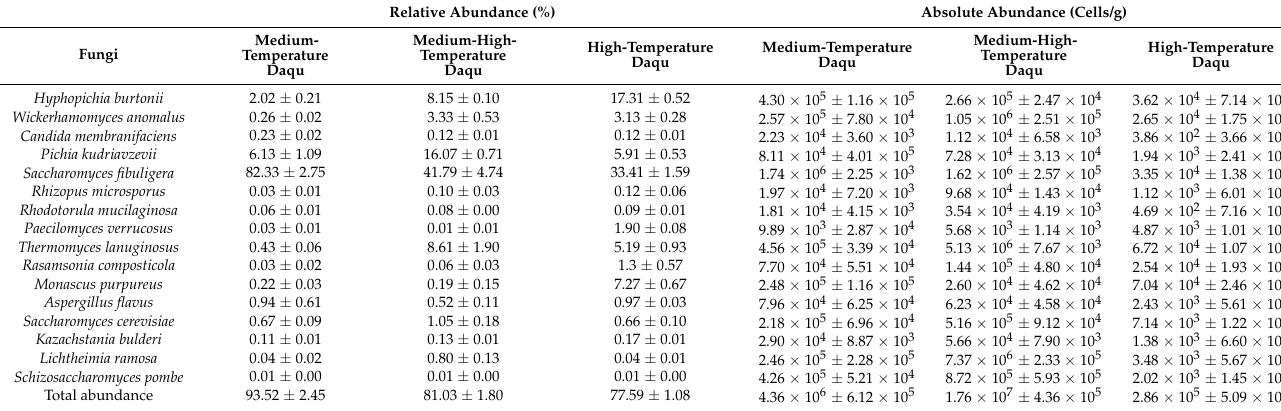
Table 3. Comparison of the relative and absolute abundance of 16 core